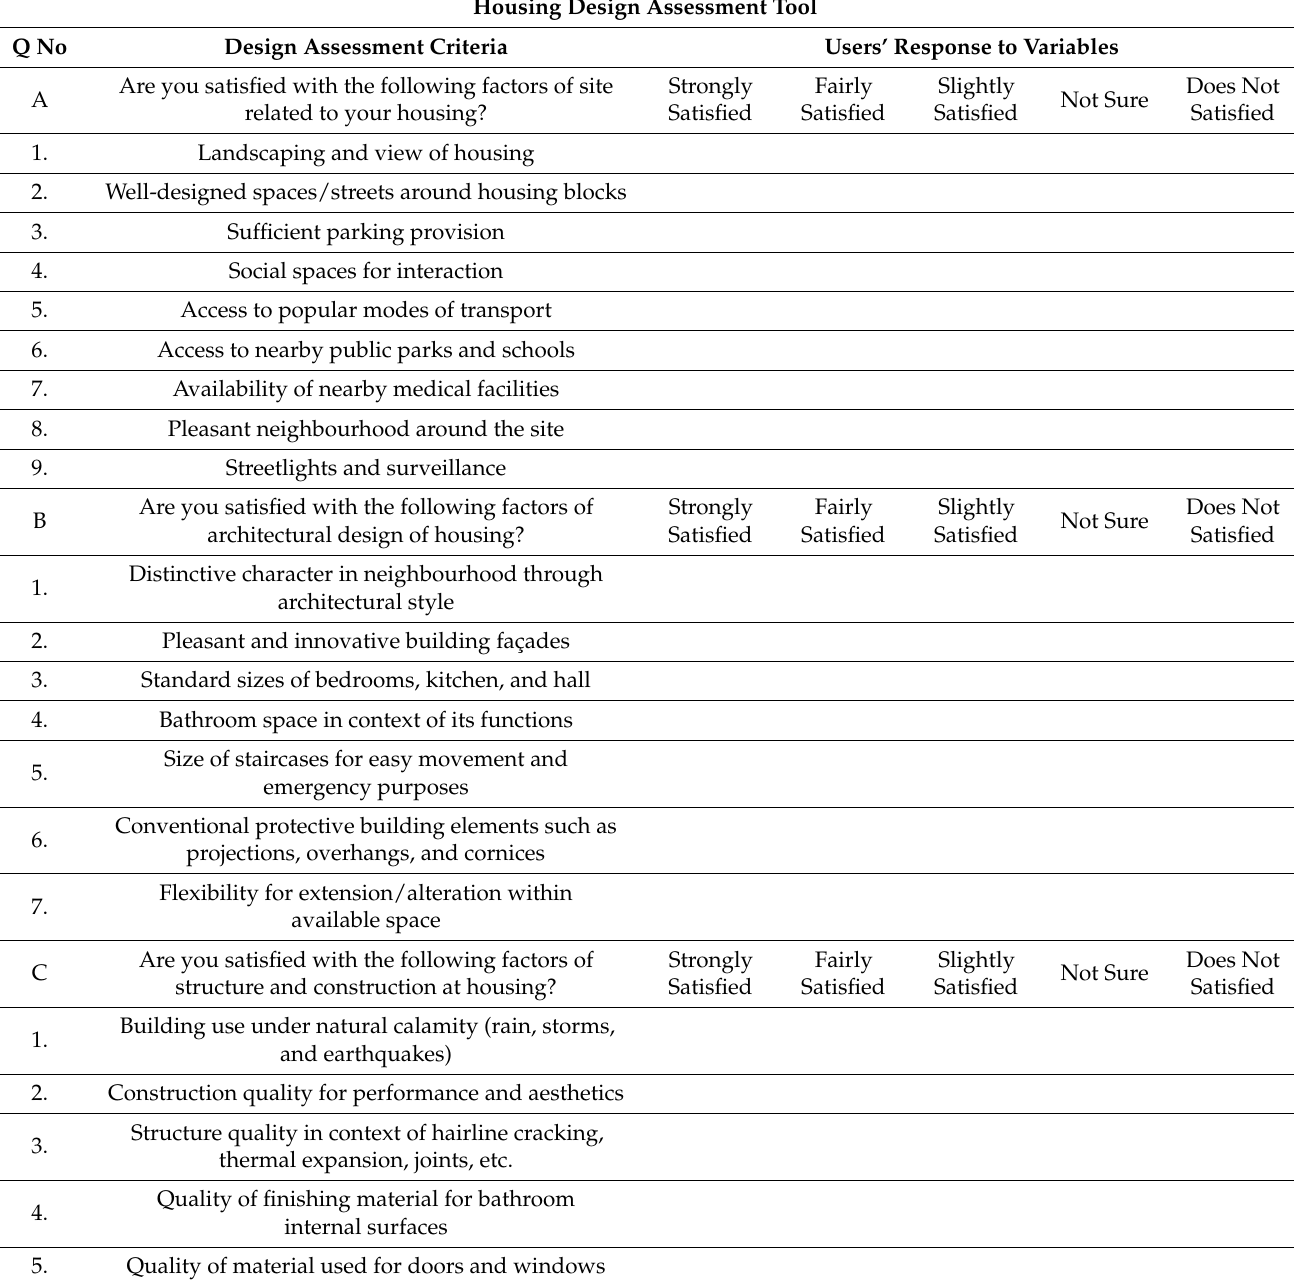
Table 3. Housing design assessment